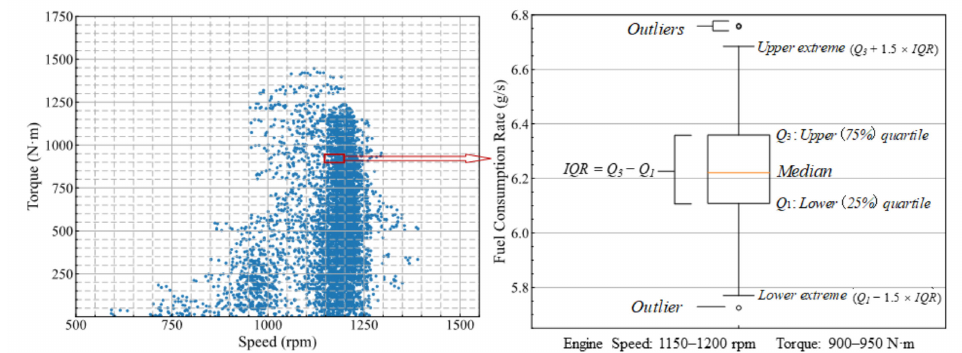
Figure 5. An example of processing fuel consumption rate